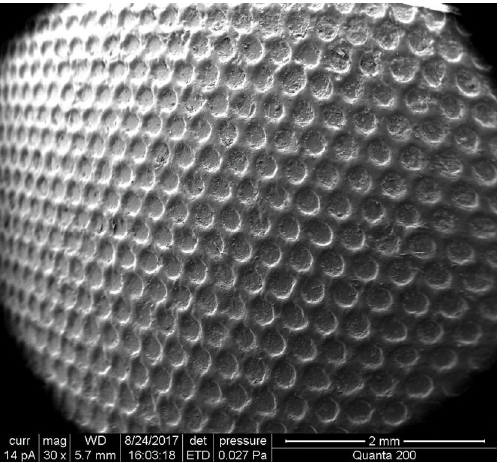
Fig. 3 SEM images of final plunger with textured surface (micro- dimples, height 50